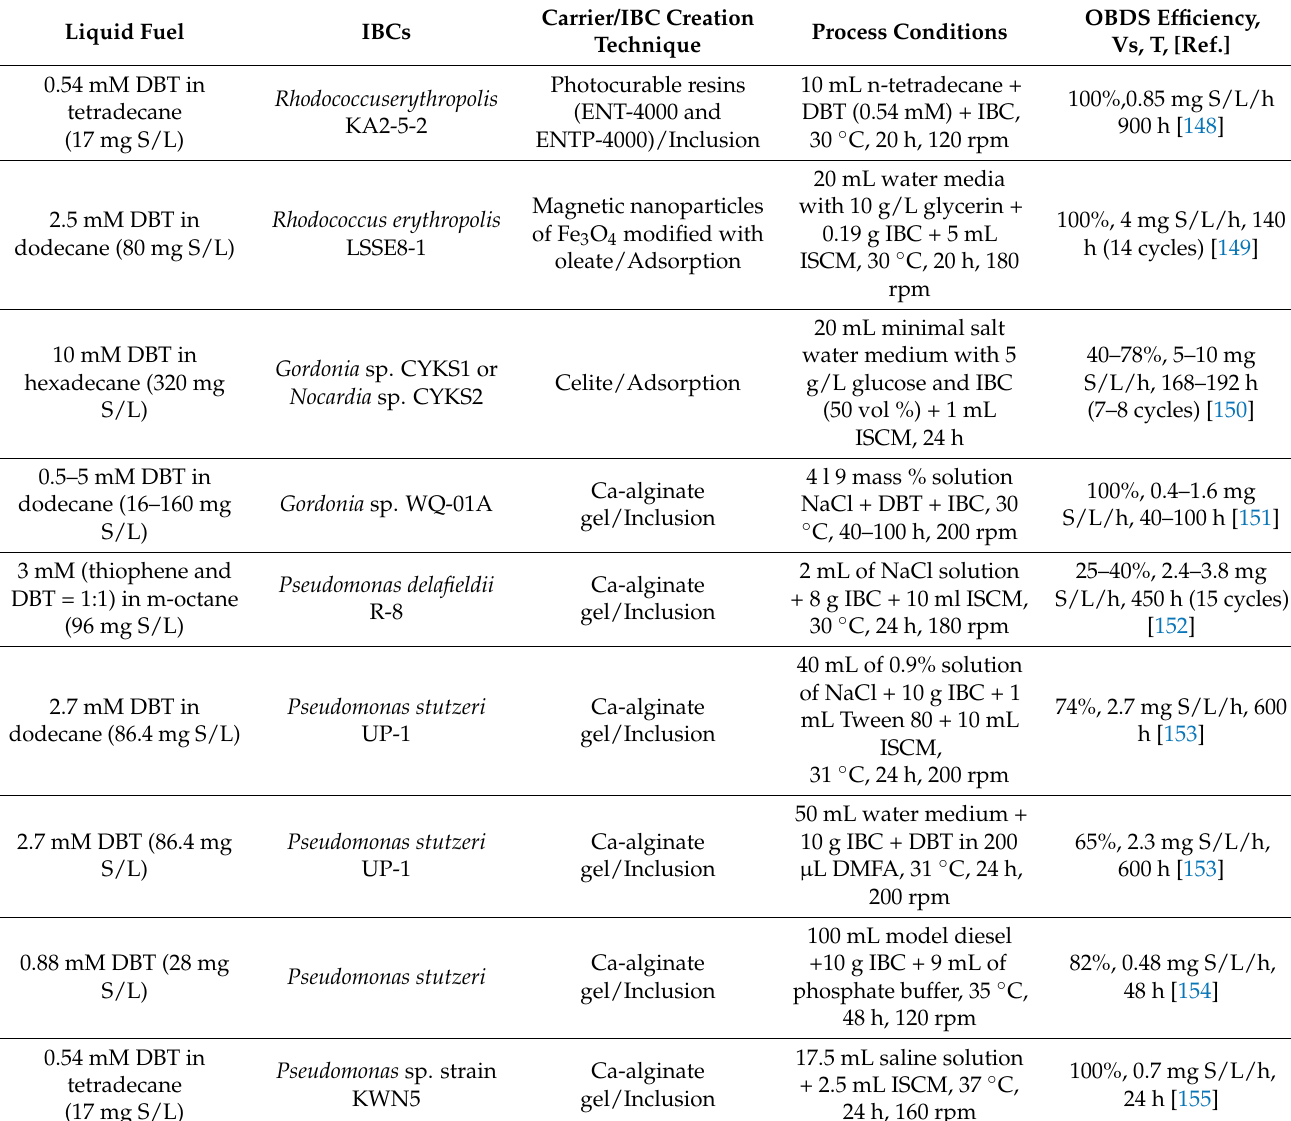
Table 4. Examples of using IBCs in OBDS processes via